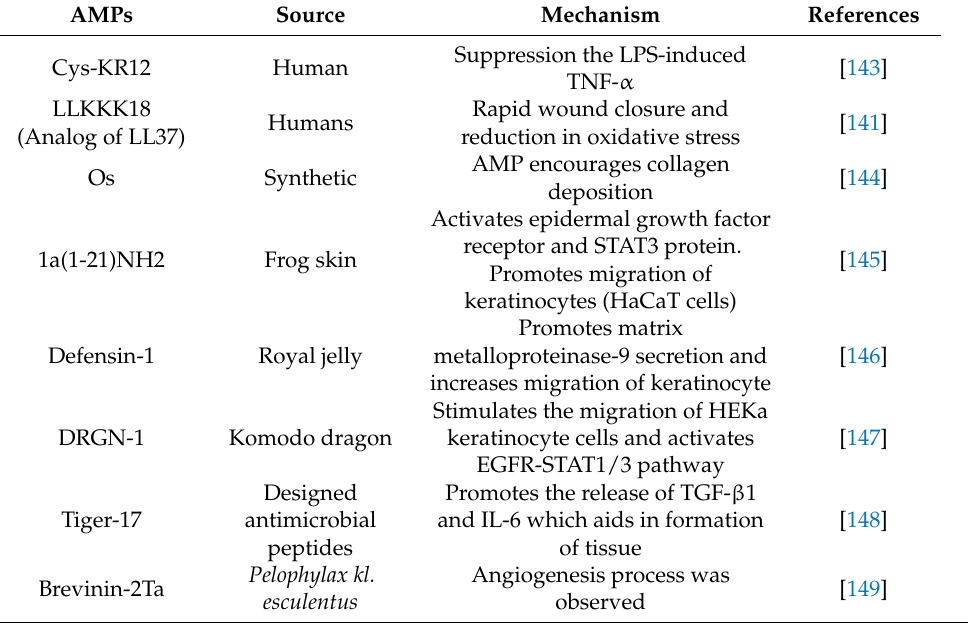
Table 8. List of some of the AMPs that suggest wound-healing